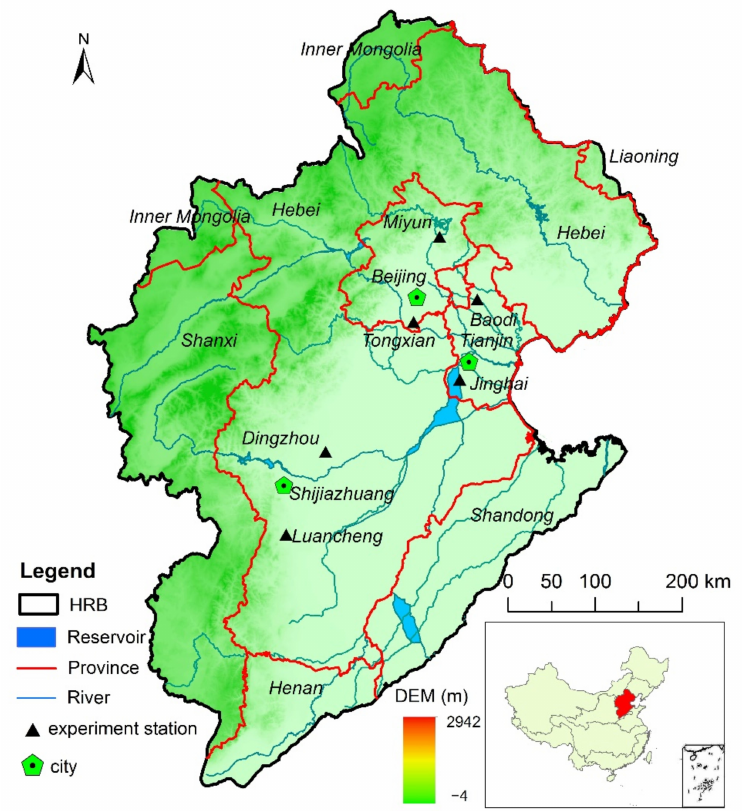
Figure 1. Locations of the study areas and agricultural experiment